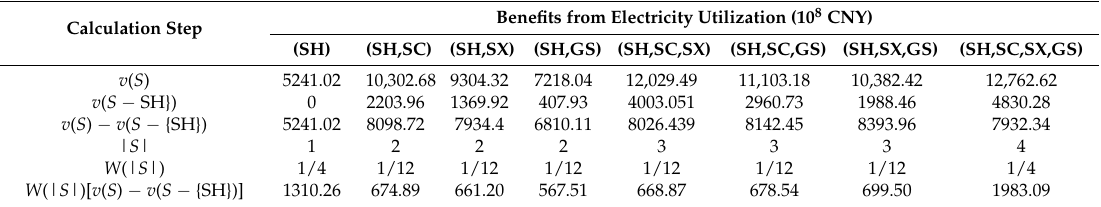
Table 12. Calculation of the benefit allocation under the CESM for Shanghai in